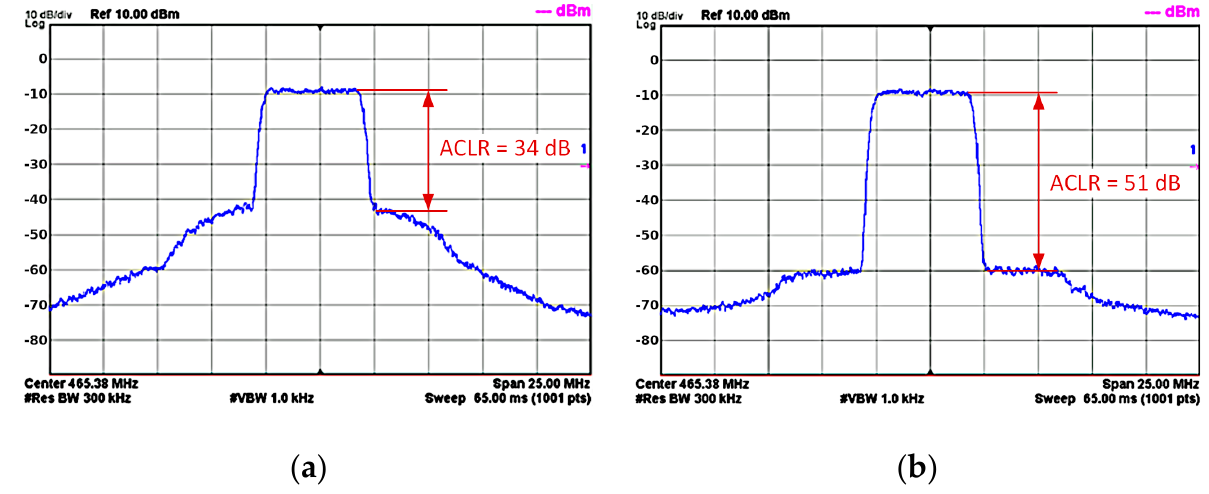
Figure 8. Prototype of the 4-channel RF front-end for the LTE band B31 (PCB dimensions: 22 × 33 cm).